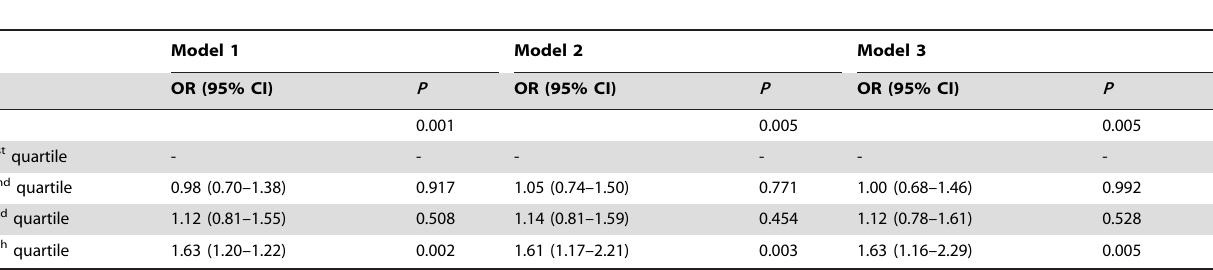
Table 4. Odds ratio for albuminuria in each quartile of estimated 24-h urine sodium with the first quartile as a control.